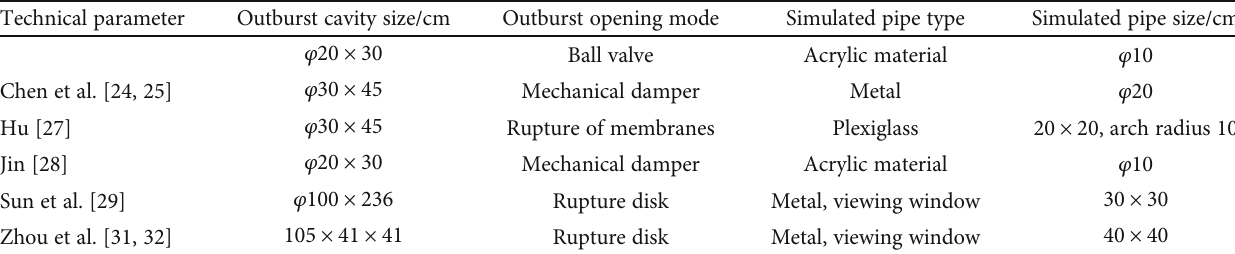
Figure 2: The visual simulation experimental device of outburst coal-gas fl ow. 1. High-pressure gas cylinder; 2. outburst chamber; 3. pneumatic solenoid valve; 4. visual simulation pipeline; 5. sensors; 6. high-speed camera. Table 1: Main parameters of the device and the existing